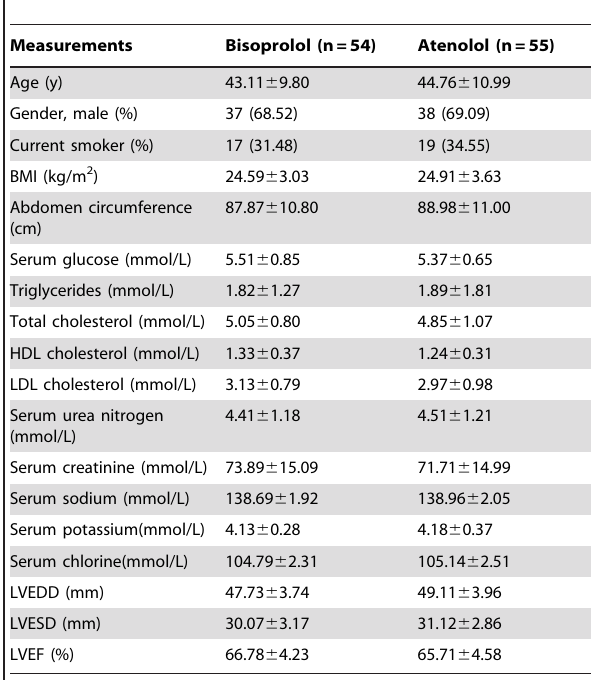
Table 1. Clinical characteristics of the study population